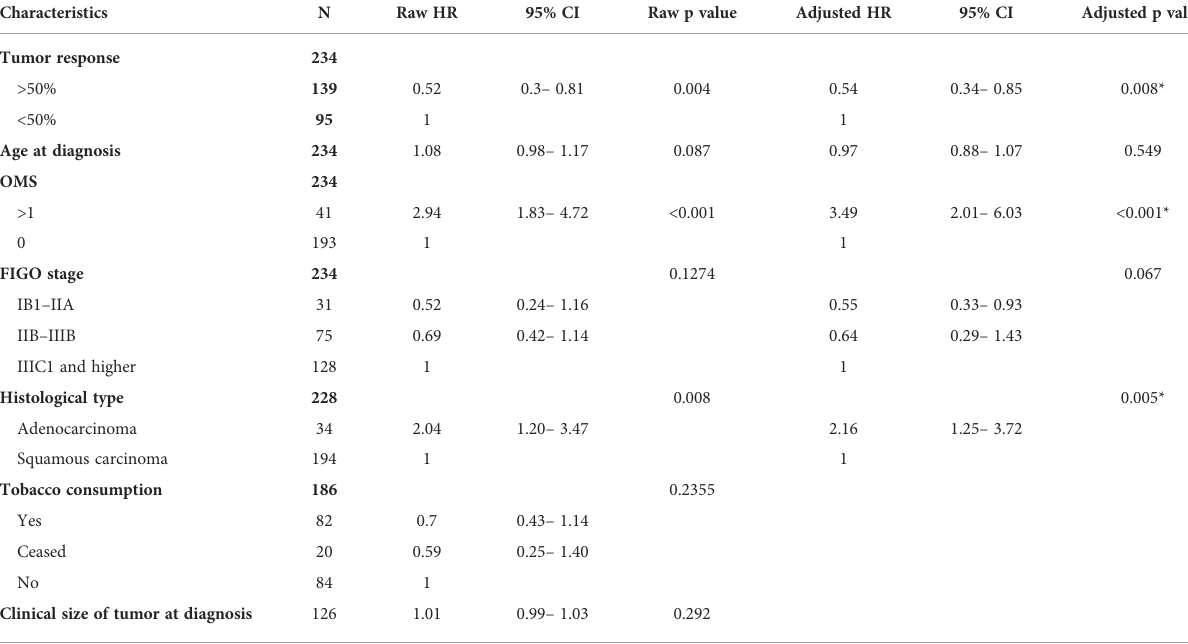
TABLE 2 Prognostic value for disease-free survival using univariate and multivariate analyses.